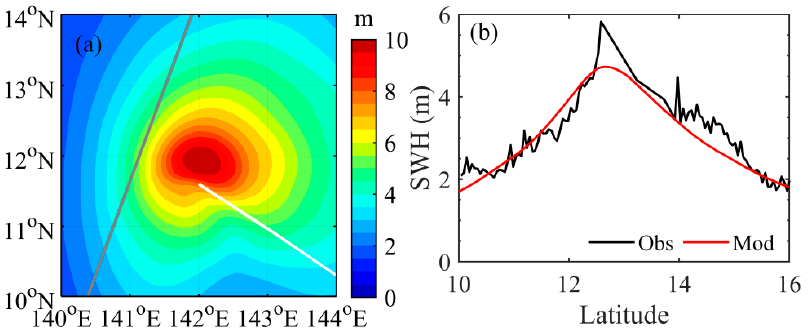
Figure 4. ( a ) Simulated significant wave height at 0000 UTC 04 July 2016. The white line is the TC track and the gray line is the tandem track of the Jason-2 satellite. ( b ) significant wave height (SWH) comparison between observation and model during 0424 and 0427 UTC 04